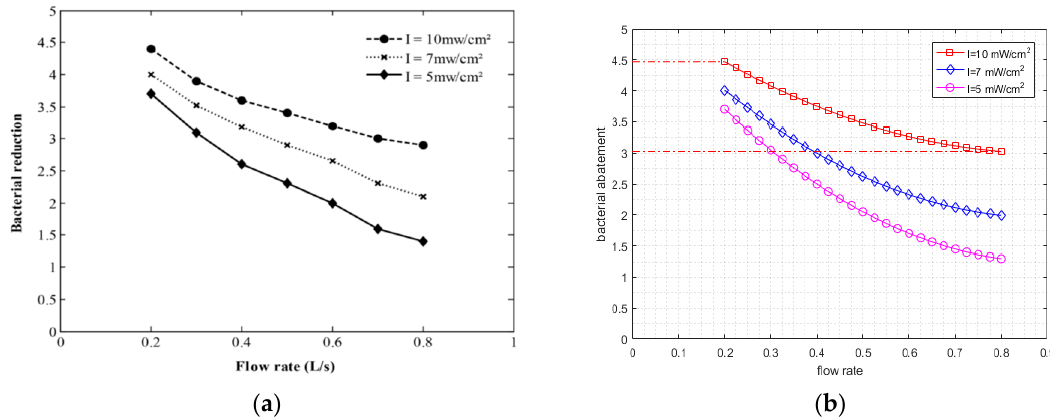
Figure A1. Comparison between characteristic curves: (a) experimental data; (b) parametrized curves